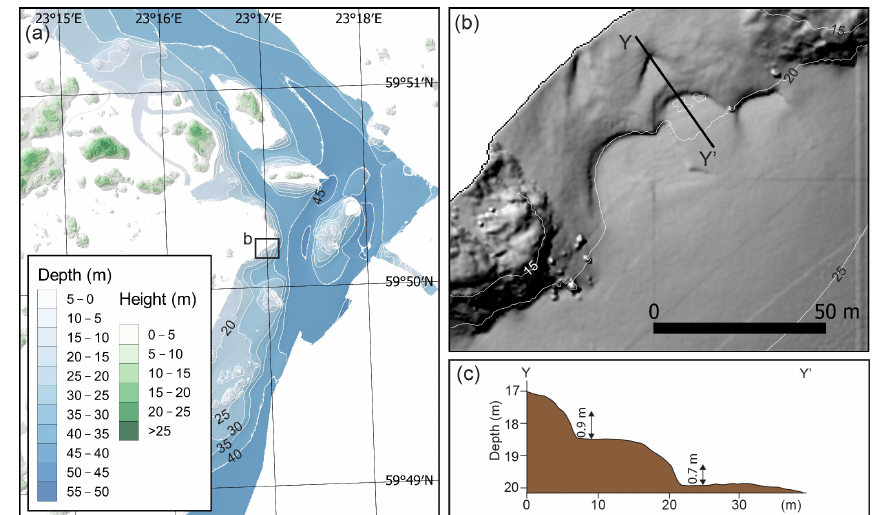
Figure 3. Multibeam bathymetry of the studied area east of Tvärminne Zoological Station in the southern Finland archipelago. (a) Overview of the sea floor bathymetry in the vicinity of the only set of terraces mapped in this area, shown in (b) . (c) Bathymetric profile from Y to Y (cid:48) across two terraces. The profile location is shown in (c) .